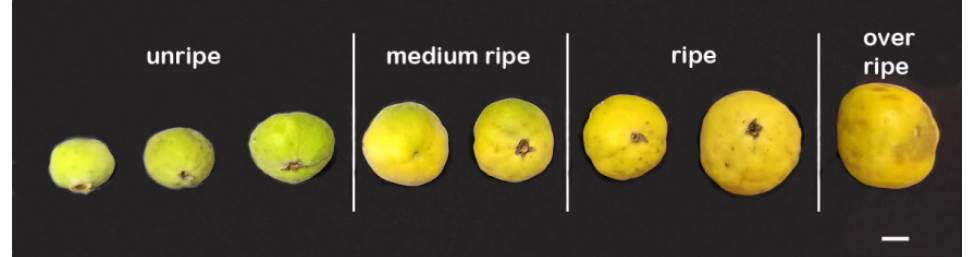
Figure 1. H. edulis fruit at different development stages. Bar = 1 cm.